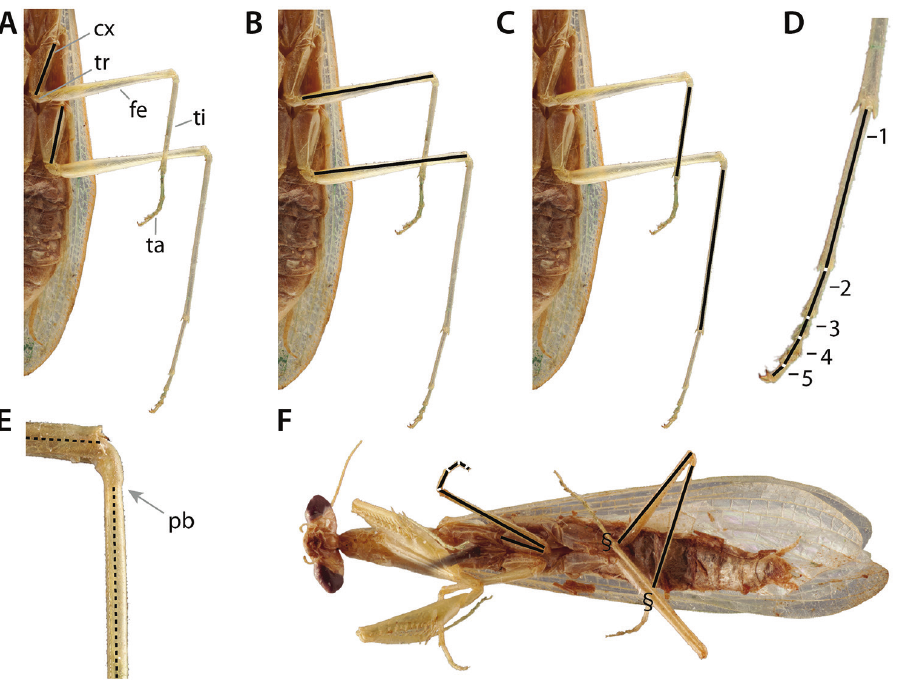
Figure 28. Meso- and metathoracic leg measurement standards. Solid black lines indicate approximate location to take length and width measurements. Dashed black lines demonstrate approximate locations for measurement endpoints. Prepared Ilomantis ginsburgae Brannoch & Svenson, 2016 meso- and meta- thoracic leg length measurements, ventral view ( A – E ): A meso- and metathoracic coxal length B meso- and metathoracic femoral length C meso- and metathoracic tibial length D tarsal length measurements with lines 1–5 indicating contiguous tarsomere measurements E approximate location of endpoints for the meso- and metathoracic femora and tibiae measurements. F Unprepared I. ginsburgae , ventral view, meso- and metathoracic leg length measurements. Note: in unprepared specimens, obtaining certain measurements might be impossible due to appendage overlap, thus necessitating the relaxing and re- mounting of such specimens. Sectional sign (§) represents potential area where overlap can occur and re- laxation and re-mounting is needed to take accurate measurements. Abbreviations: cx = coxa; fe = femur; pb = proximal bend in the tibia ta = tarsus; ti = tibia; tr =